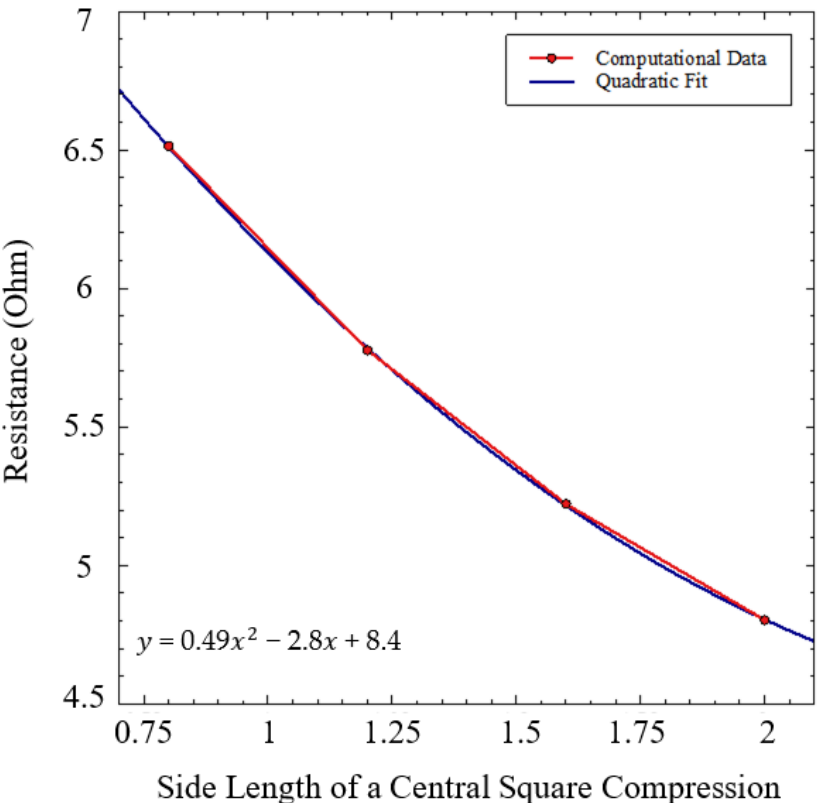
Figure 7. The resistance as a function of expanding deformation area was determined. An expanding square compression (see Figure 6) at a constant 0.4 N force was simulated using a parametric sweep of the square’s side length. A quadratic function was fit to the to the data points, with the equation of the line displayed.